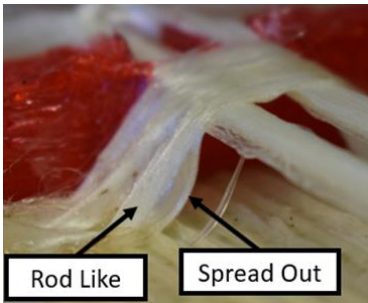
Figure 21. Effect of tow exit angle from the nozzle on truss core segment